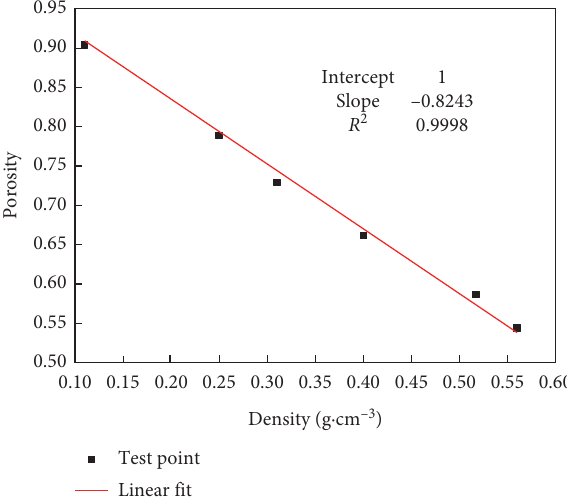
Figure 9: Relationship between porosity and density.